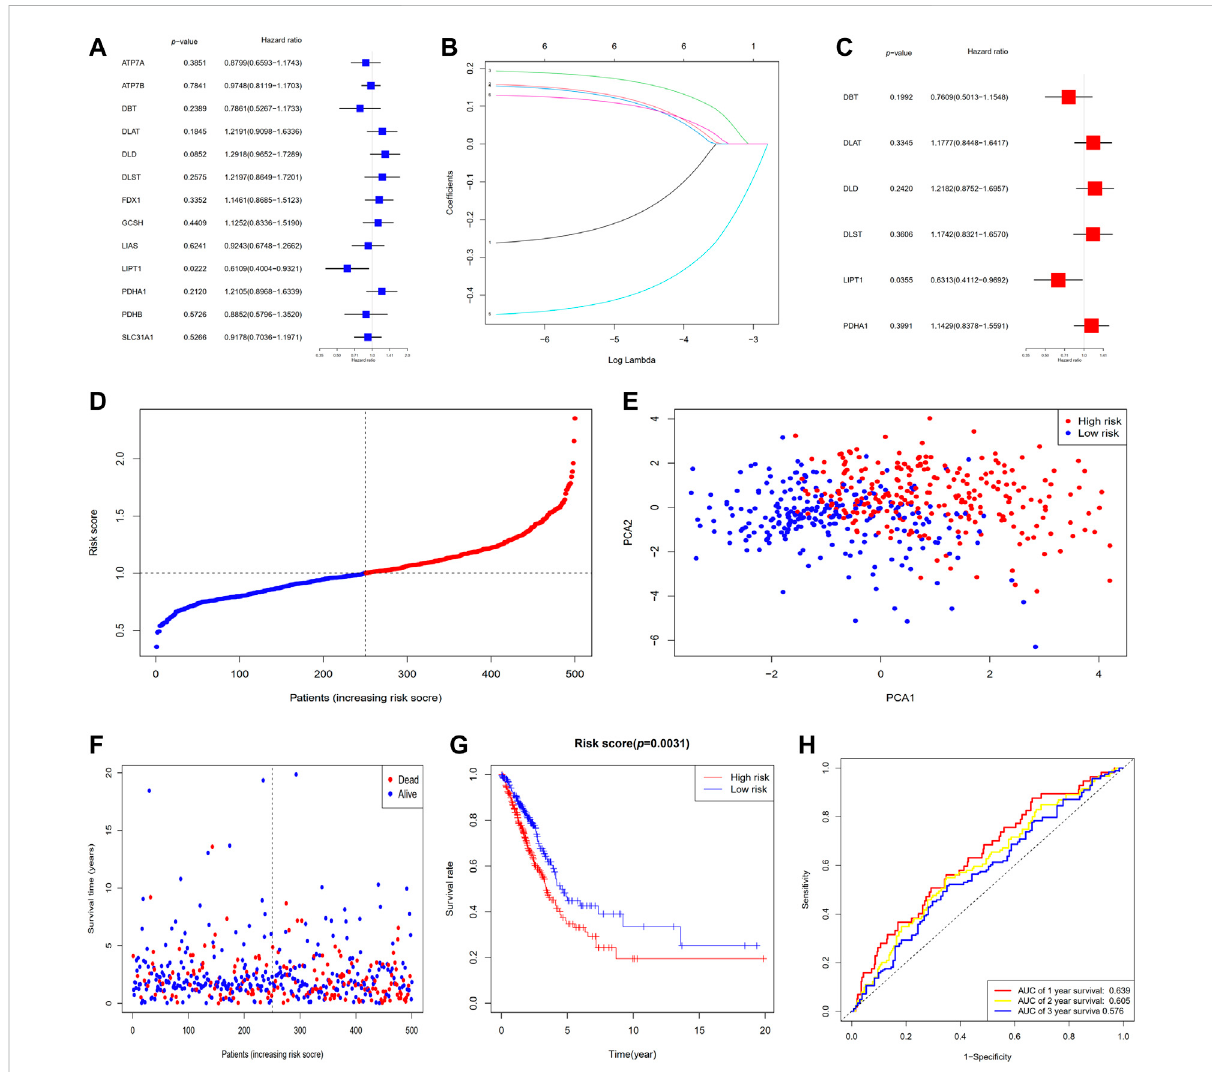
FIGURE 3 The establishment of a risk signature for the TCGA dataset. (A) OS analysis utilizing univariate Cox regression for each of the 6 cuproptosis- associated genes with p < 0.3. (B) LASSO regression analysis of the six genes associated with OS. (C) Analysis of OS utilizing multivariate Cox regression for the six genes associated with OS. (D) Patients are classi fi ed according to their risk scores. (E) PCA plot for patients with LUAD depending on their risk scores. (F) Each patient ’ s survival probability (low- and high-risk groups are displayed on the left and right sides of the dotted line, respectively). (G) KM survival study of patients classi fi ed as having high or low risks. (H) ROC curves proved the risk score ’ s predictive effectiveness. AUC, area under the ROC